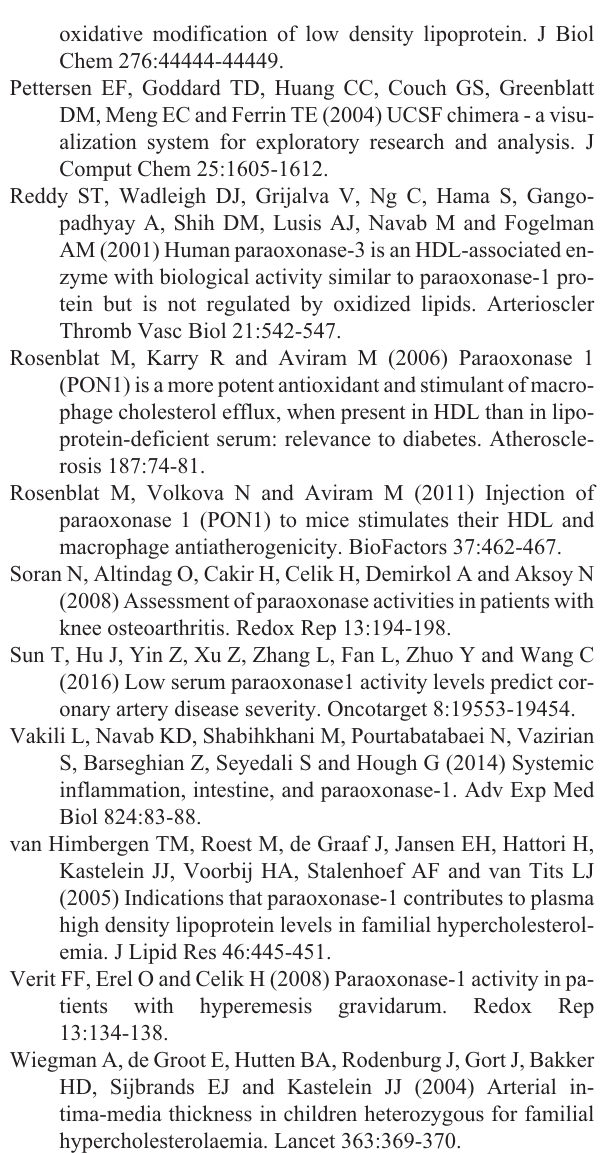
Figure S1 - RFLP results of PON1